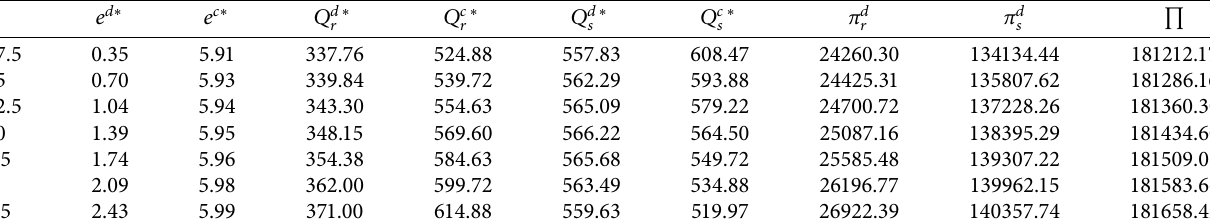
Table 8: Sensitivity analysis of free riding β .